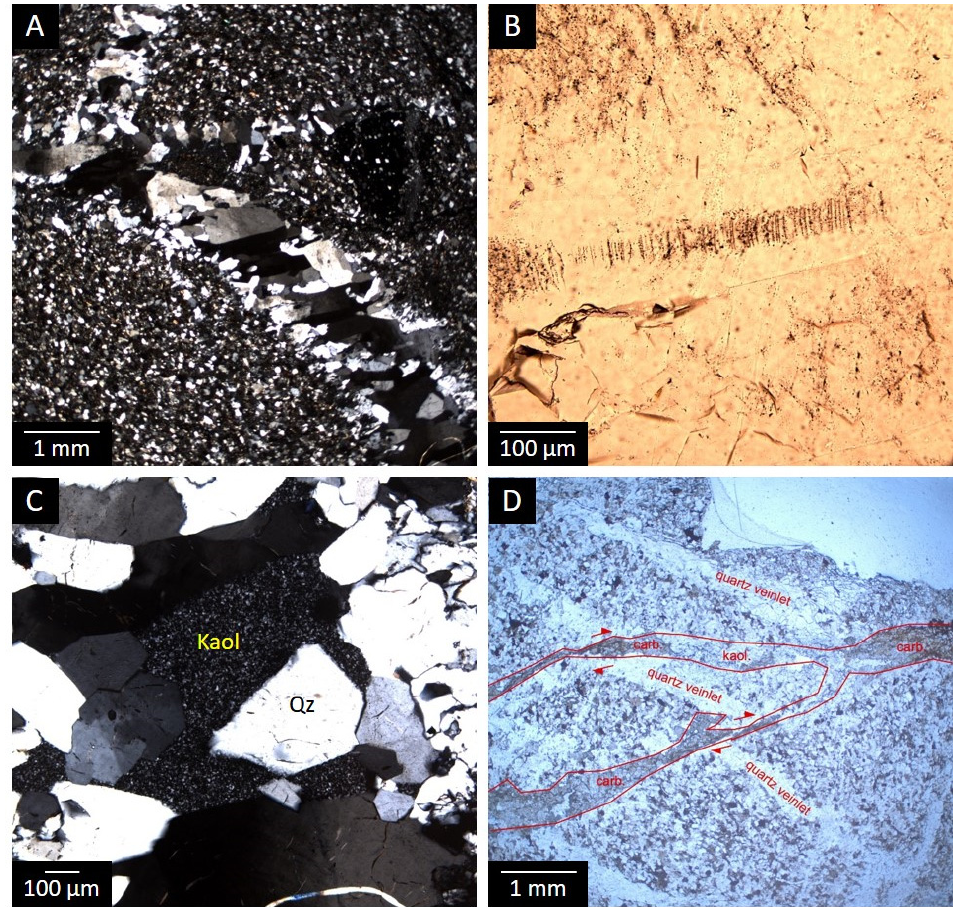
Figure 3. ( A ): general view of the romb quartz texture (crossed polarized light). ( B ): quartz zonation presenting a crystal core with numerous inclusions, particularly FIs (polarized light). ( C ): euhedral quartz crystal (type 1) enrobed with kaolinite in the middle of the vein. ( D ): distribution of the two veinlet types with criteria of relative chronology and displacement (microphotograph).